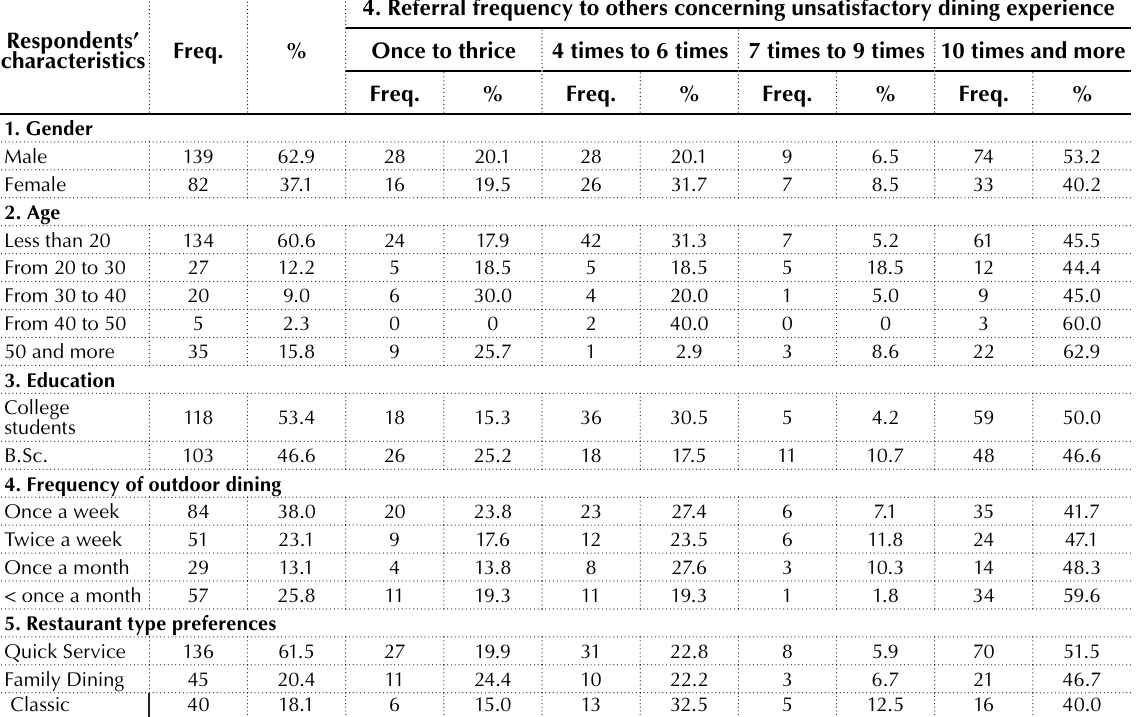
Table 3. Associating WOM referral intentions to consumers’